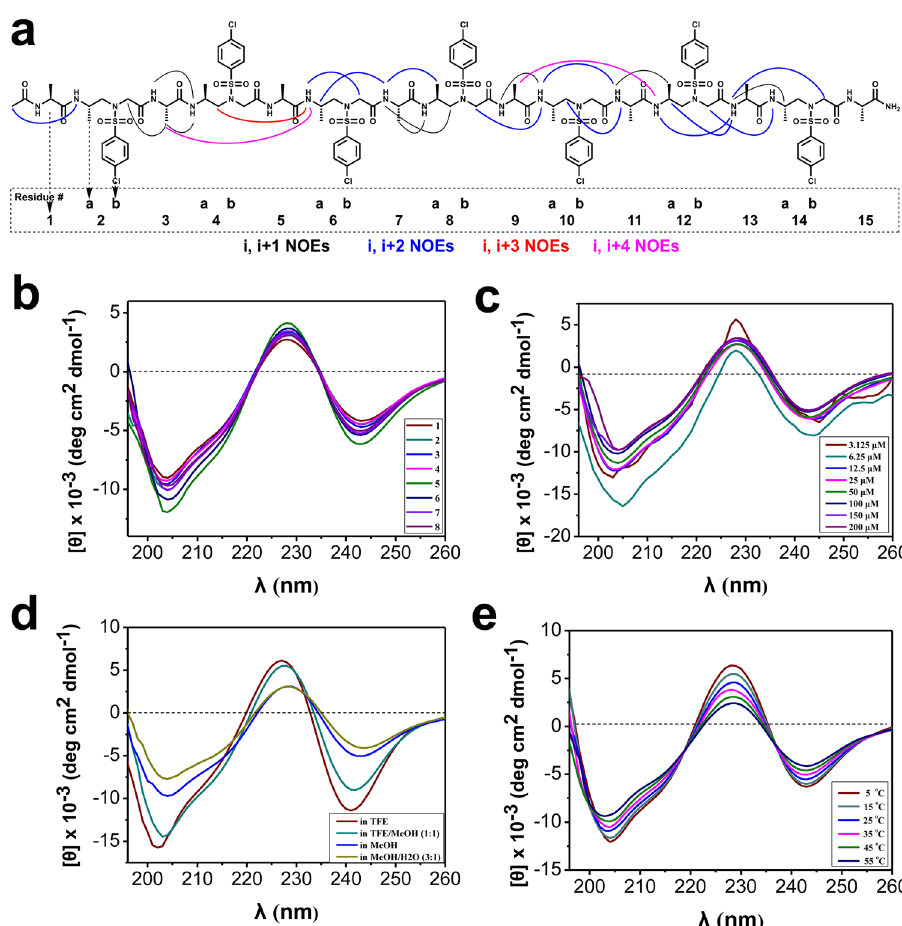
Fig. 4 Solution structures of foldamers. a Summary of detected NOESY cross-peaks (200 ms mixing time) of foldamer 8 between protons on nonadjacent residues in CD 3 OH (4 mM concentration, 10 °C). Four types of NOEs are displayed in different color. Each L -sulfono- γ -AA peptide unit is considered as two residues since it is equal to two α -amino acids in length. b CD spectra of compounds 1 ‒ 8 (100 μ M) measured at room temperature in CH 3 OH. c CD spectra of compound 8 in CH 3 OH at various concentrations at room temperature. d CD spectra of compound 8 (100 μ M) in various solvents at room temperature. e CD spectra of compound 8 (100 μ M) in CH 3 OH at various